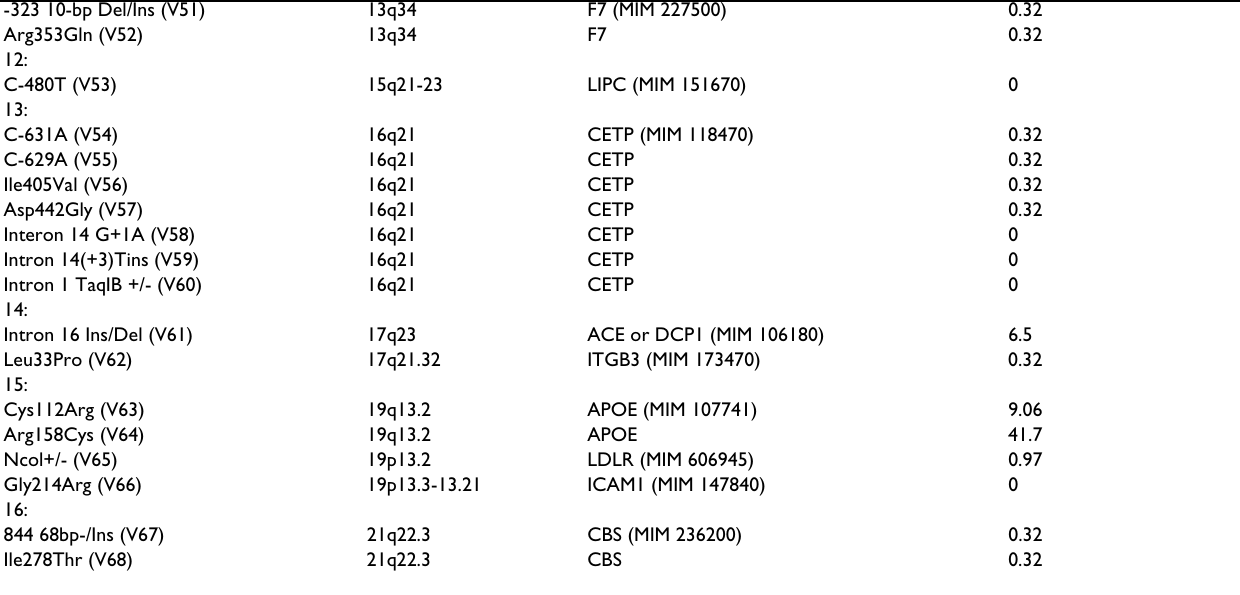
Table 2: Polymorphisms used in genotyping assay.